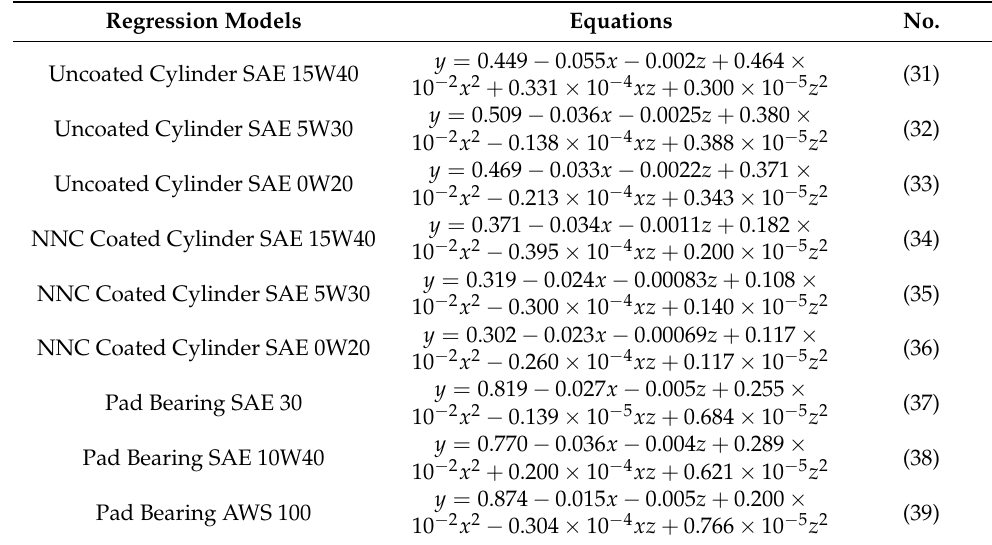
Table 7. Summary of the regression models. Regression